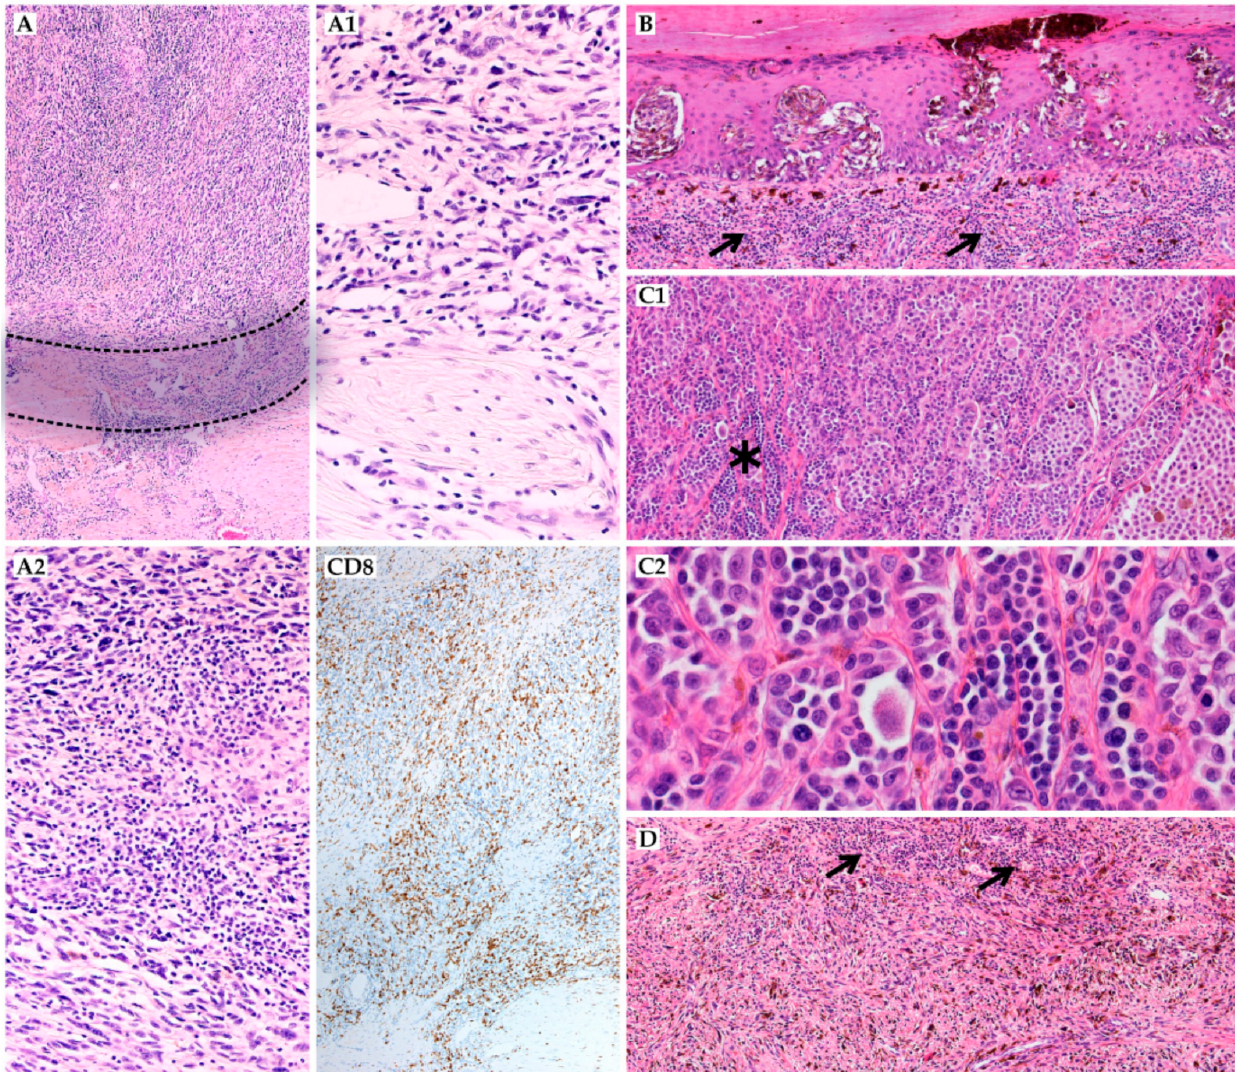
Figure 1. Histopathological evaluation of tumor-infiltrating lymphocytes (TILs); ( A ) brisk representative TILs according to Clark scale (HE, (haematoxylin–eosin), 20 × ), both intratumoral (( A2 ), HE, 200 × ) and peritumoral (( A1 ), HE, 200 × ) areas should be assessed; marked and diffuse CD8 + cells (20 × ); ( B ) in early stage melanomas (pT1) the brisk and dense TILs may cover up melanoma cells in vertical-growth phase (HE, 40 × ); ( C1 ) (HE, 100 × ) and ( C2 ) (HE, 400 × )—some melanoma cells (see: asterisk) in low magnification may resemble TILs (see: arrows); ( D ) evaluation of TILs in highly melanocytic tumors may be challenging, in IHC the red chromogen or bleaching the slides may be helpful (HE, 20 ×